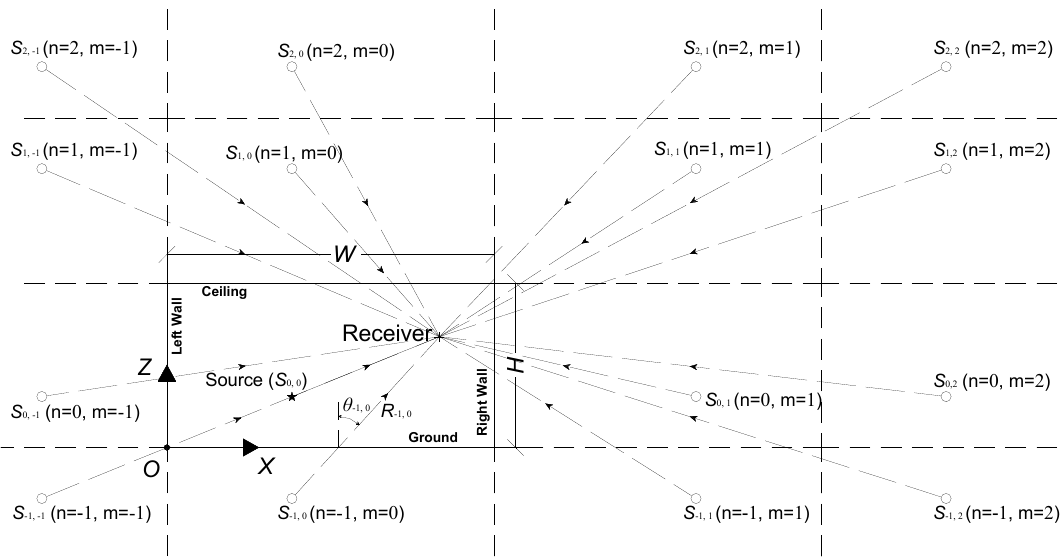
Figure 1. Cross-sectional geometry of a long rectangular space with height H and width W, and the image sources formed by multiple reflections on its four boundaries.